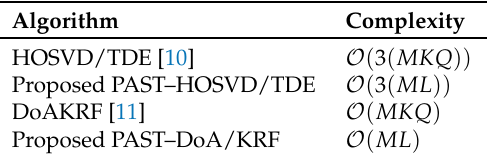
Table 1. Numerical Complexity of the